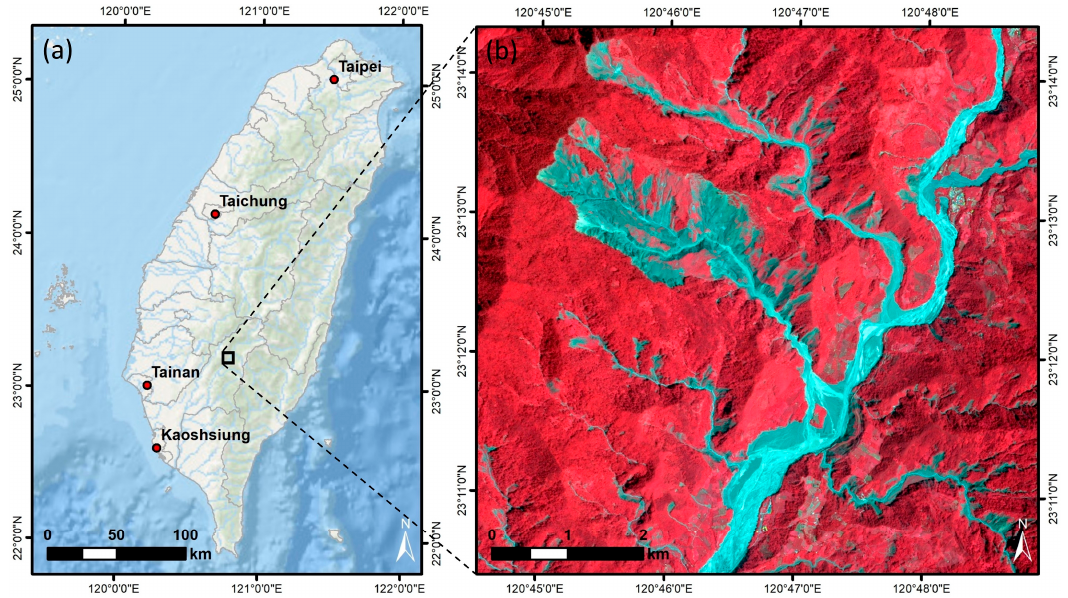
Figure 1. ( a ) Location of the study area in south-central Taiwan (R.O.C.; background data: ©